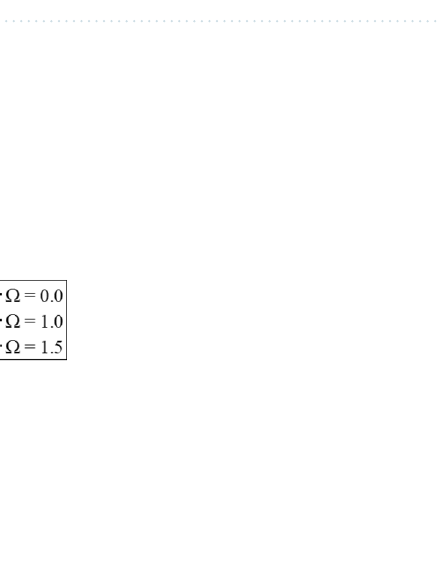
Figure 18 represents that the angular velocity parameter has significant effects on the displacement distribu- tions. The three curves start from the position r = 5.0 with zero values, and each curve has a peak point. The absolute value of the displacement increases when the value of the angular velocity parameter increases. The absolute value of the peak points of the displacement takes the following order